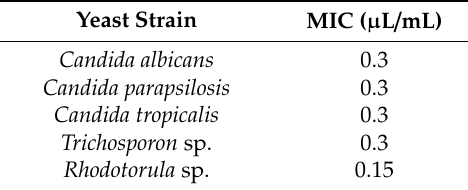
Table 4. Minimum inhibitory concentrations (MIC) of Candida strains determined with agar dilution method. Yeast Strain MIC ( µ L / mL) Candida albicans 0.3 Candida parapsilosis 0.3 Candida tropicalis 0.3 Trichosporon sp. 0.3 Rhodotorula sp. 0.15